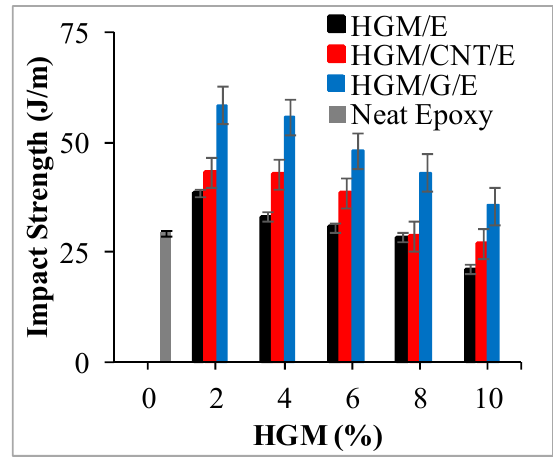
Figure 7. Impact strength of composites.